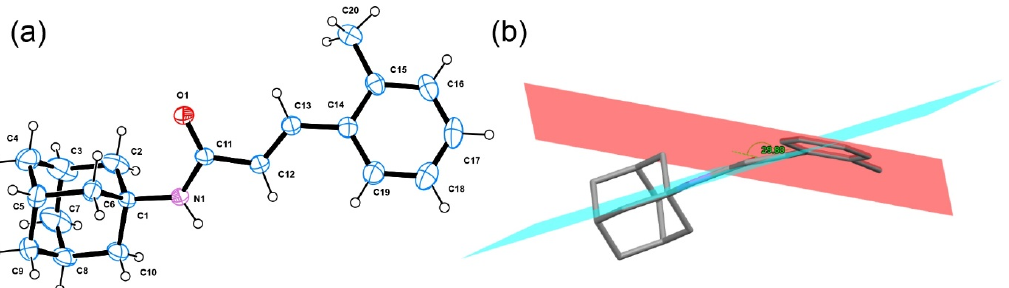
Figure 1. ( a ) ORTEP [30] view and numbering scheme of the molecule present in the asymmetric unit of ( E )– N -(2-methylcinnamoyl)-amantadine; the thermal ellipsoids were drawn with 50% probability, and hydrogen atoms are shown as small spheres with arbitrary radii. ( b ) Observed angle between the mean plane of the phenyl (C1/C15/C16/C17/C18/C19) and acrylamide (C13/C12/C11/O1/N1) moieties